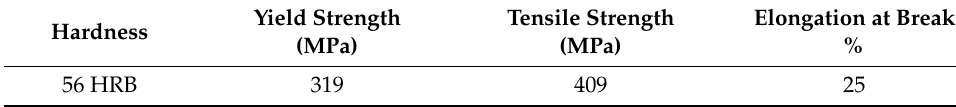
Table 2. Mechanical properties of the steel.